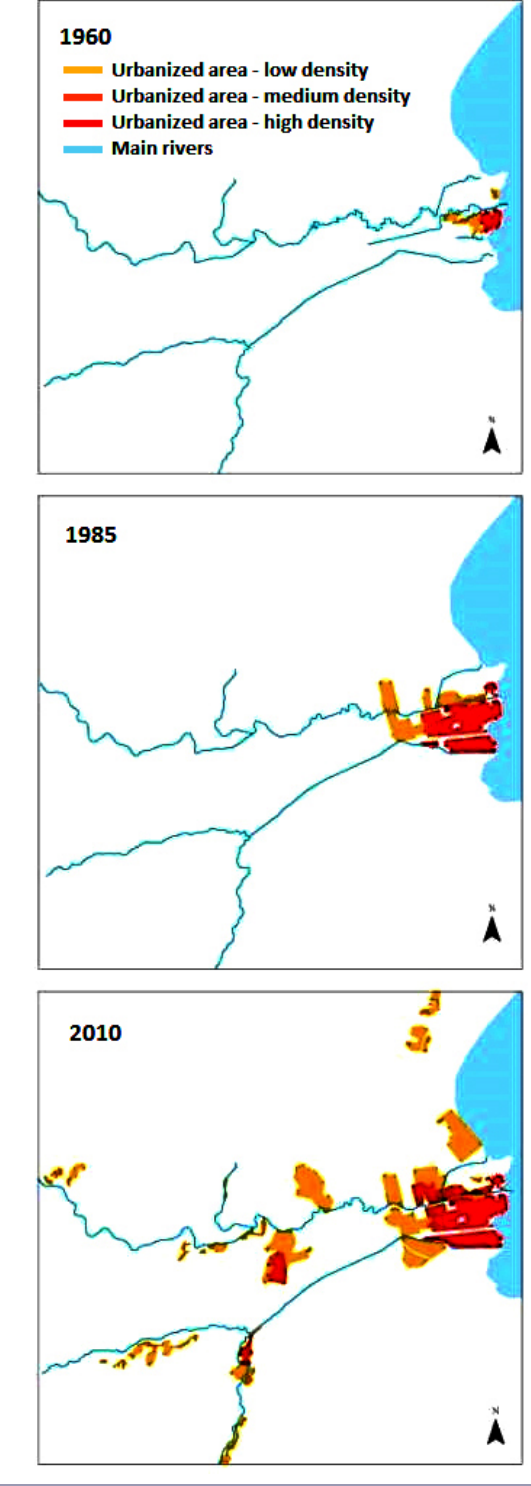
Fig. 2 . Urban growth in Paraty 1960-2010. Original sources: compilation of aerial and satellite photos and Google images build in a GIS